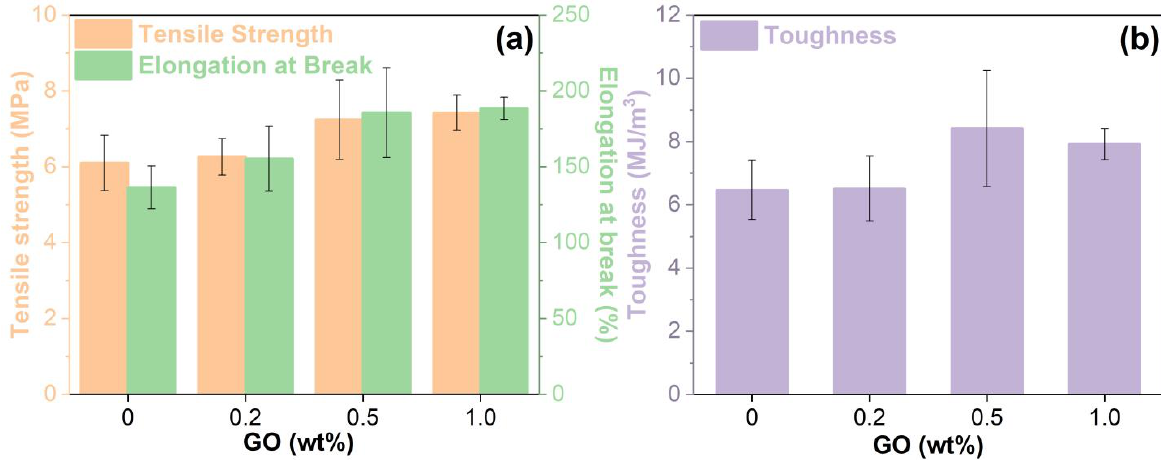
Figure 15. Mechanical properties of the unmodified and GO-modified EABCs: tensile strength, elongation at break ( a ) and toughness ( b ).